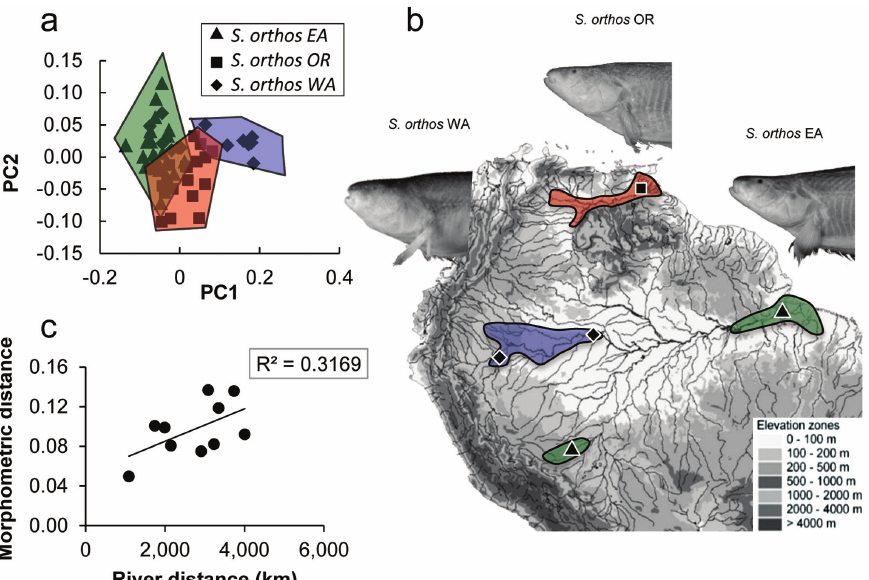
Fig. 22. Head-shape variation in Sternarchella orthos from three hydrogeographic regions of Greater Amazonia. a. Principal components analysis. Position of mouth, anus, and posterior head margin load heavily on PC1, and opercle width and position of anus and anal-fin on in PC2 (Fig. 7). EA, Eastern Amazon (green); OR, Orinoco (red); WA, Western Amazon (blue), upper Madeira included in EA on both morphometric and hydrogeographic grounds. Note the partial separations among the three populations. b. Geographic distributions and representative phenotypes of S. orthos in the three regions. c. Significant correlation (p= 0.045) between morphometric and river distance among five locations (symbols in panel B). Morphometric distances from CVA of head shape data; river distances as thalweg measured in Google